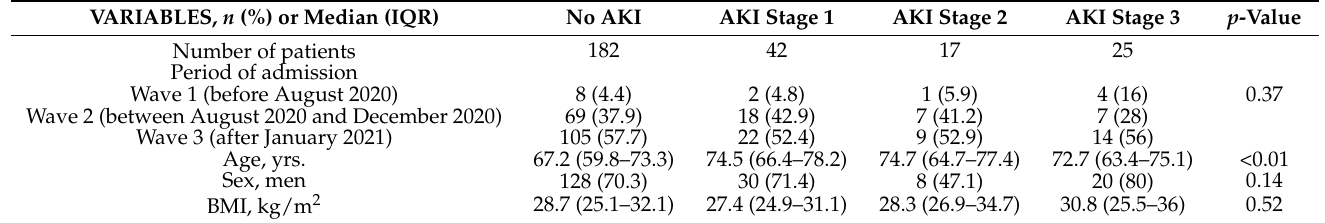
Table 2. Characteristics of the critically ill COVID-19 patients according to the severity of the acute kidney injury (KDIGO